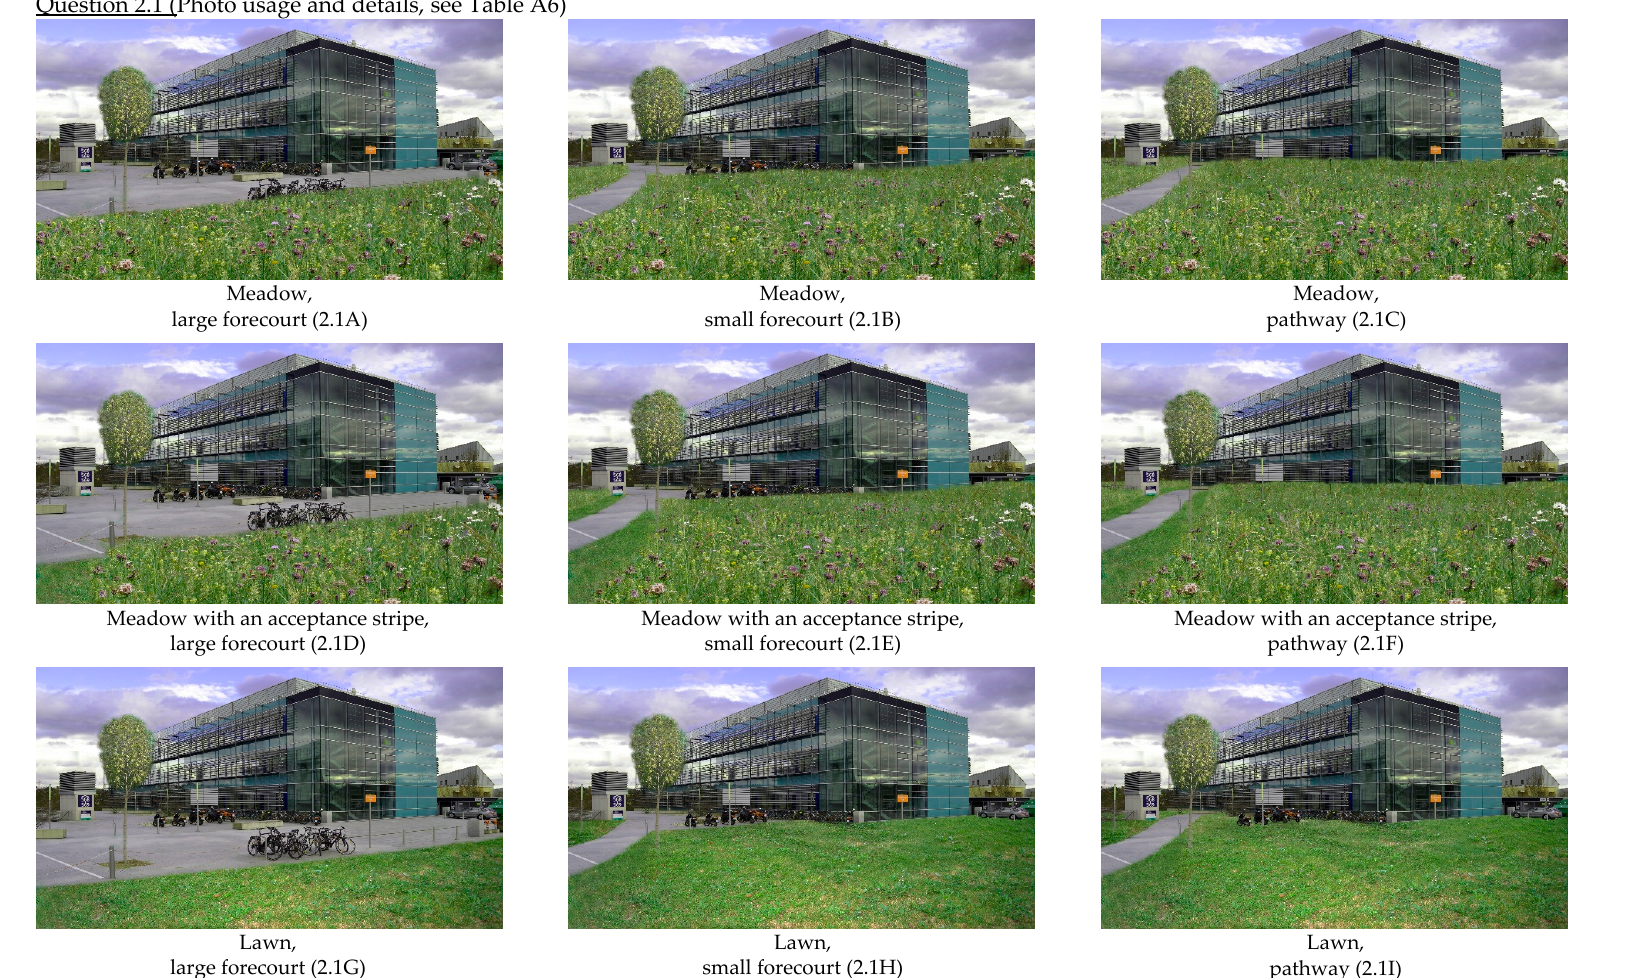
Figure 2. The aim of Question 2.1 was to establish the existence of a preference for a certain type of green space or a preference for the relative area of asphalt in relation to the green area. For further explanations, see